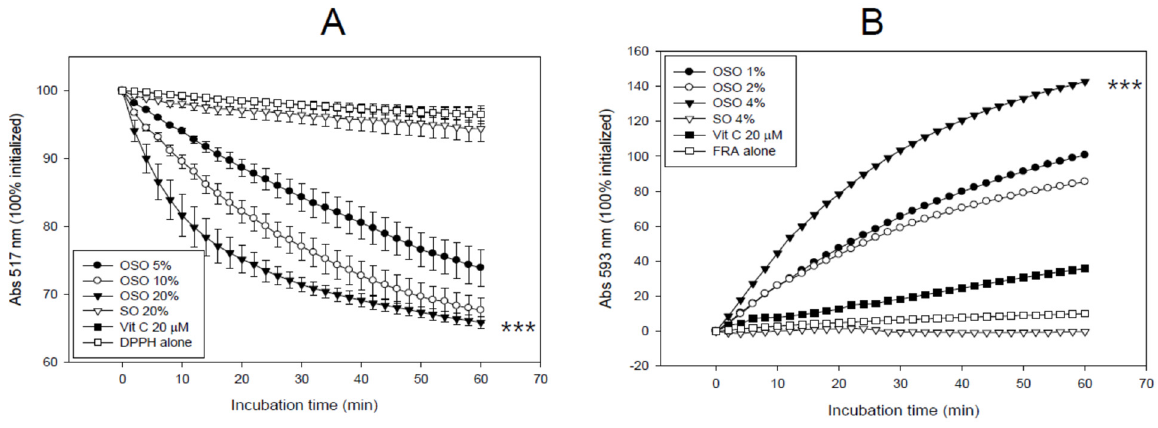
Figure 1. Antioxidant ability of ozonated sunflower oil (OSO). ( A ) DPPH radical scavenging activity. *** p < 0.005 compared to SO; ( B ) Ferric ion reduction ability. *** p < 0.005 compared to SO.